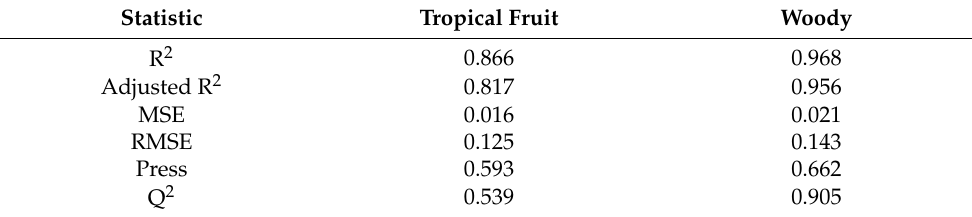
Table 6. Quality indexes of the multiple linear regression models on flavour Chardonnay data. Statistic Tropical Fruit